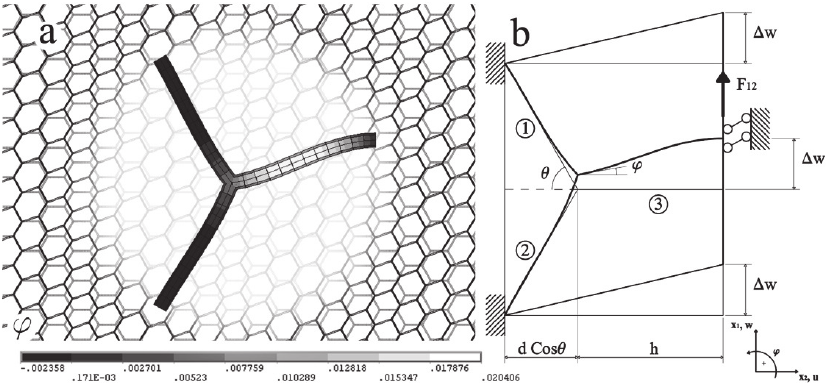
Figure 10: Hexagrid - shear test; a) deformed configuration; b) definition of the RVE.